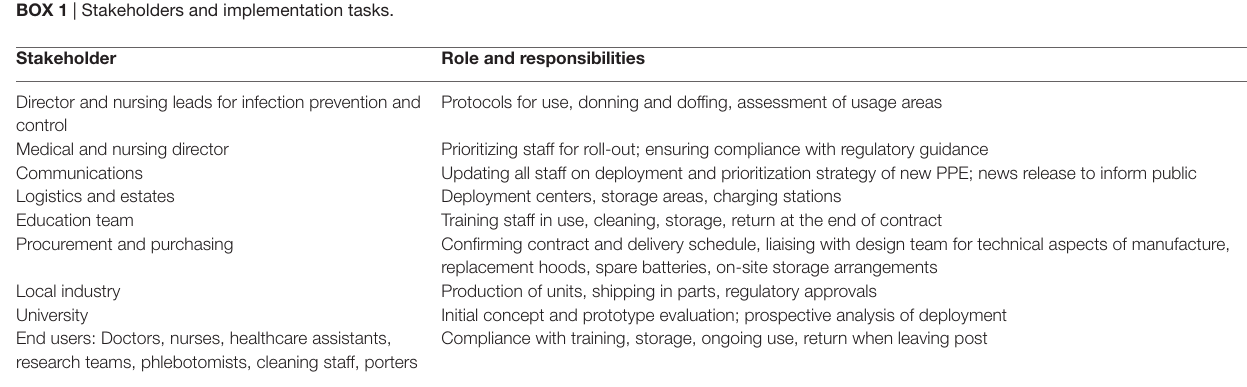
BOX 1 | Stakeholders and implementation